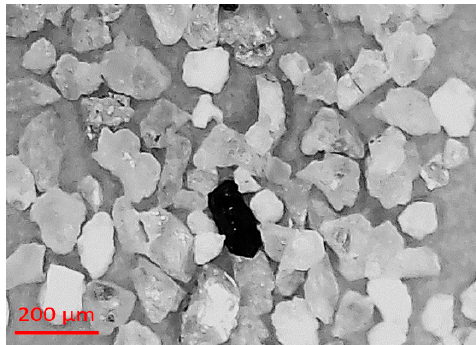
Figure 3. SEM image of silt grain particles.